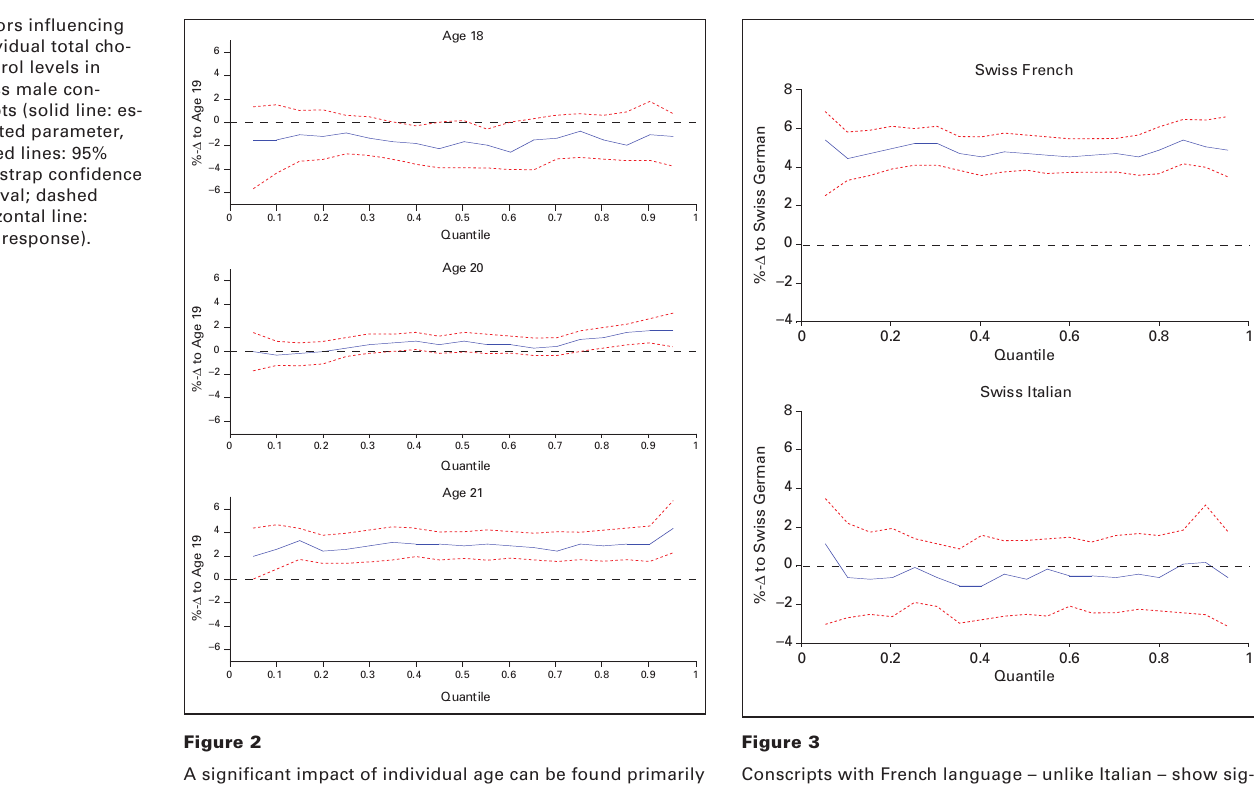
Conscripts with French language – unlike Italian – show sig- nificantly higher cholesterol values, for all quantiles, than their German-speaking counterparts (reference group).